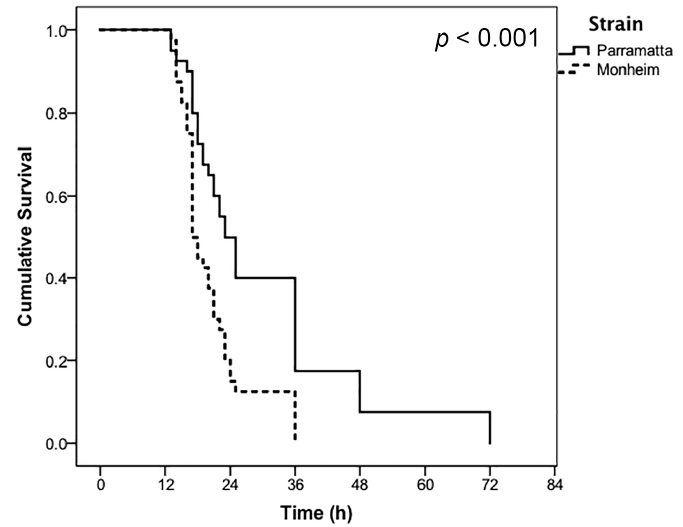
Figure 2. Proportional cumulative survival in response to continuous exposure to the half (0.5×) prescribed label rate of CimeXa Insecticide Dust of Parramatta (resistant) and Monheim (susceptible) strains of Cimex lectularius ( n = 40 bugs per strain, Monheim (susceptible) control mortality = 0%, Parramatta (resistant) control mortality at 72 h = 2.5%)